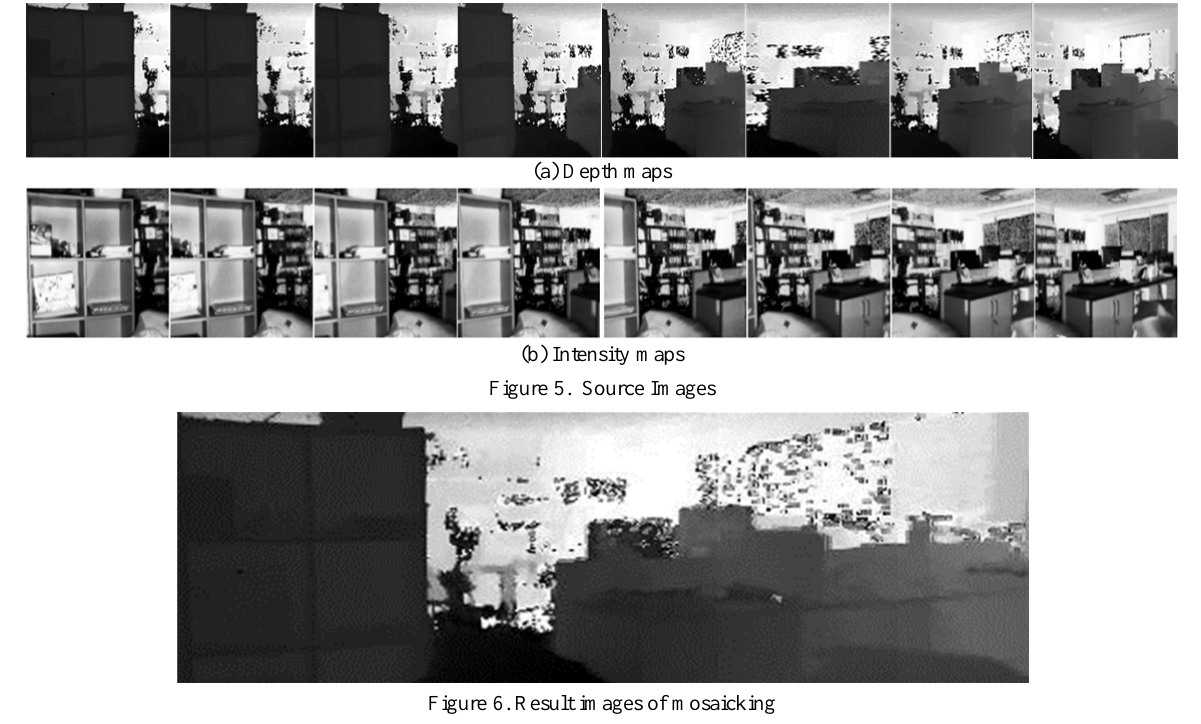
Figure 6. Result images of